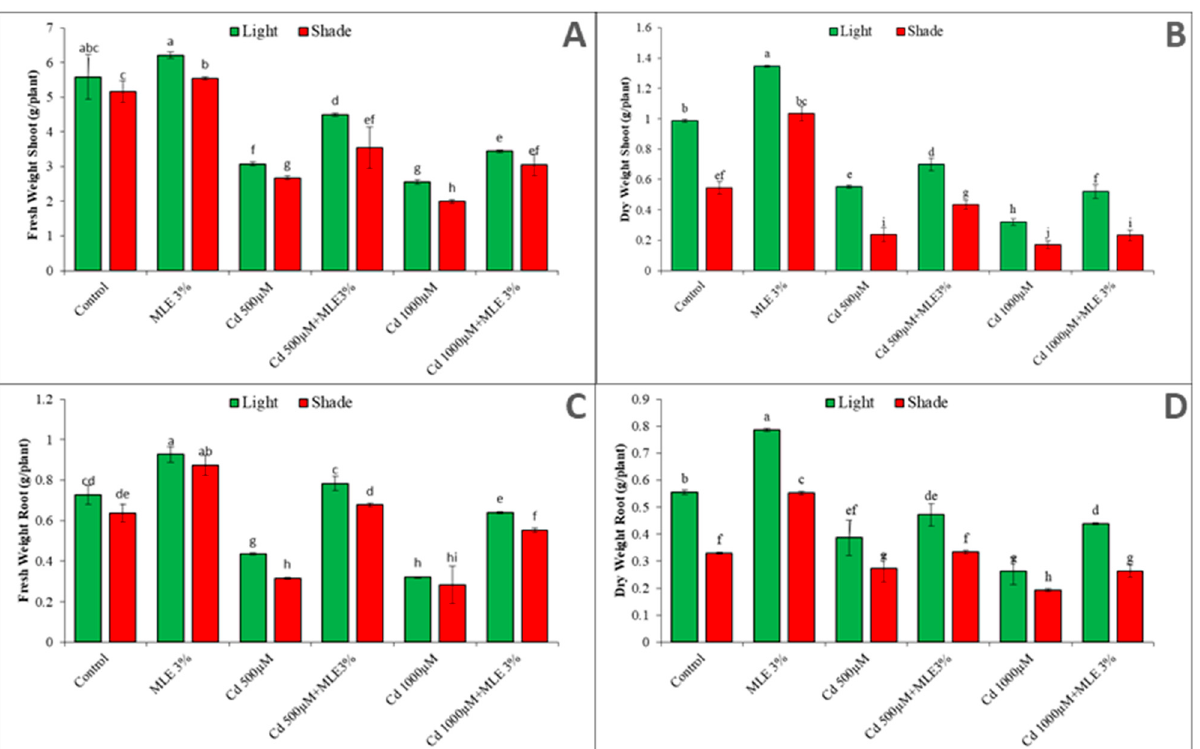
Figure 2. Effect of MLE application on fresh biomass ( A ) shoot fresh weight ( B ) shoot dry weight ( C ) root fresh weight ( D ) root dry weight, with and without Cd stress under light and subdue light. Different letters above bars represents significant differences ( p < 0.05) at each measured point. Values represent mean ± SE of three replicates of each treatment.